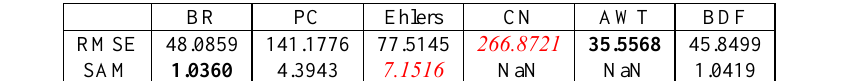
Table 11. RMSE and SAM (radian) between QuickBird multispectral and fused images using different algorithms Note: NaN indicates the very small numerical value that can not express by computer. XS BR PC Ehlers CN